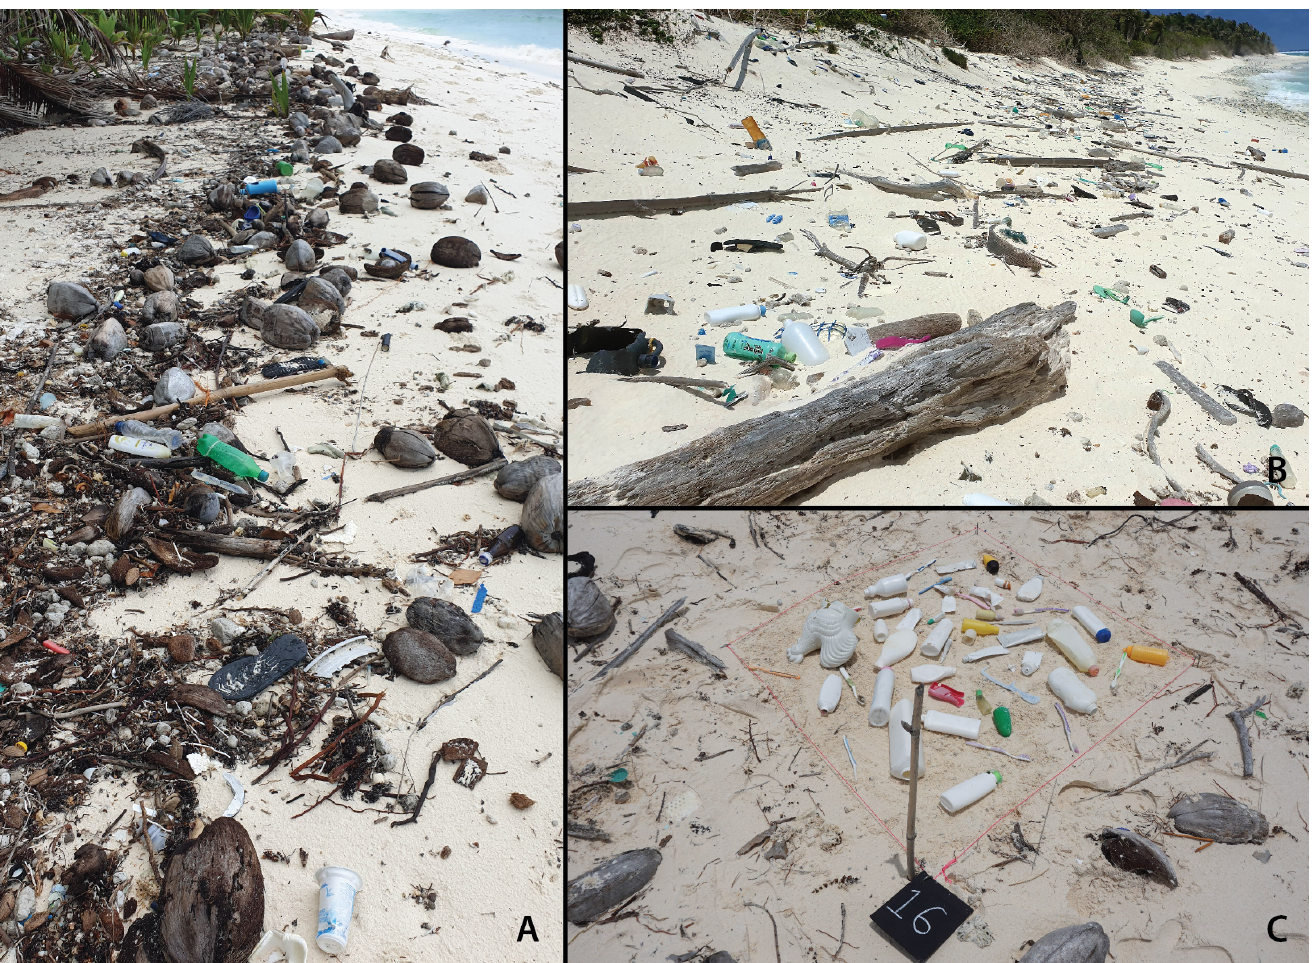
Figure 2. Marine plastic debris (MPD) on the Cocos (Keeling) Islands, February 2020 ( A ) Northern ocean-facing beach on West Island ( B ) southern ocean-facing beach on South Island ( C ) a quadrat setup with an artificially created MPD surface cover of